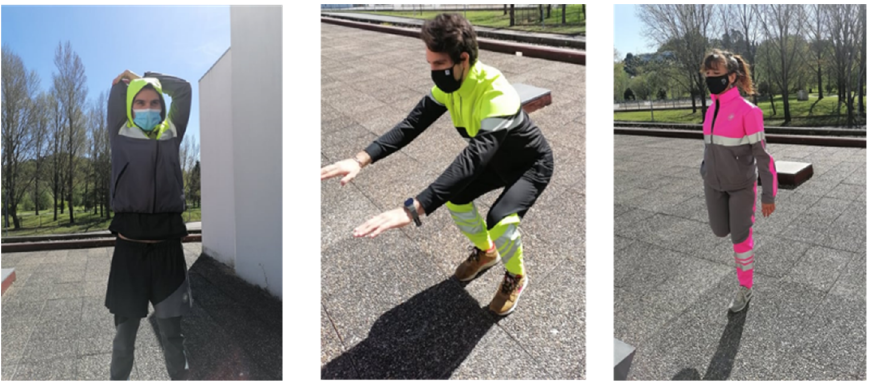
Figure 8. End-users’ evaluation tests.